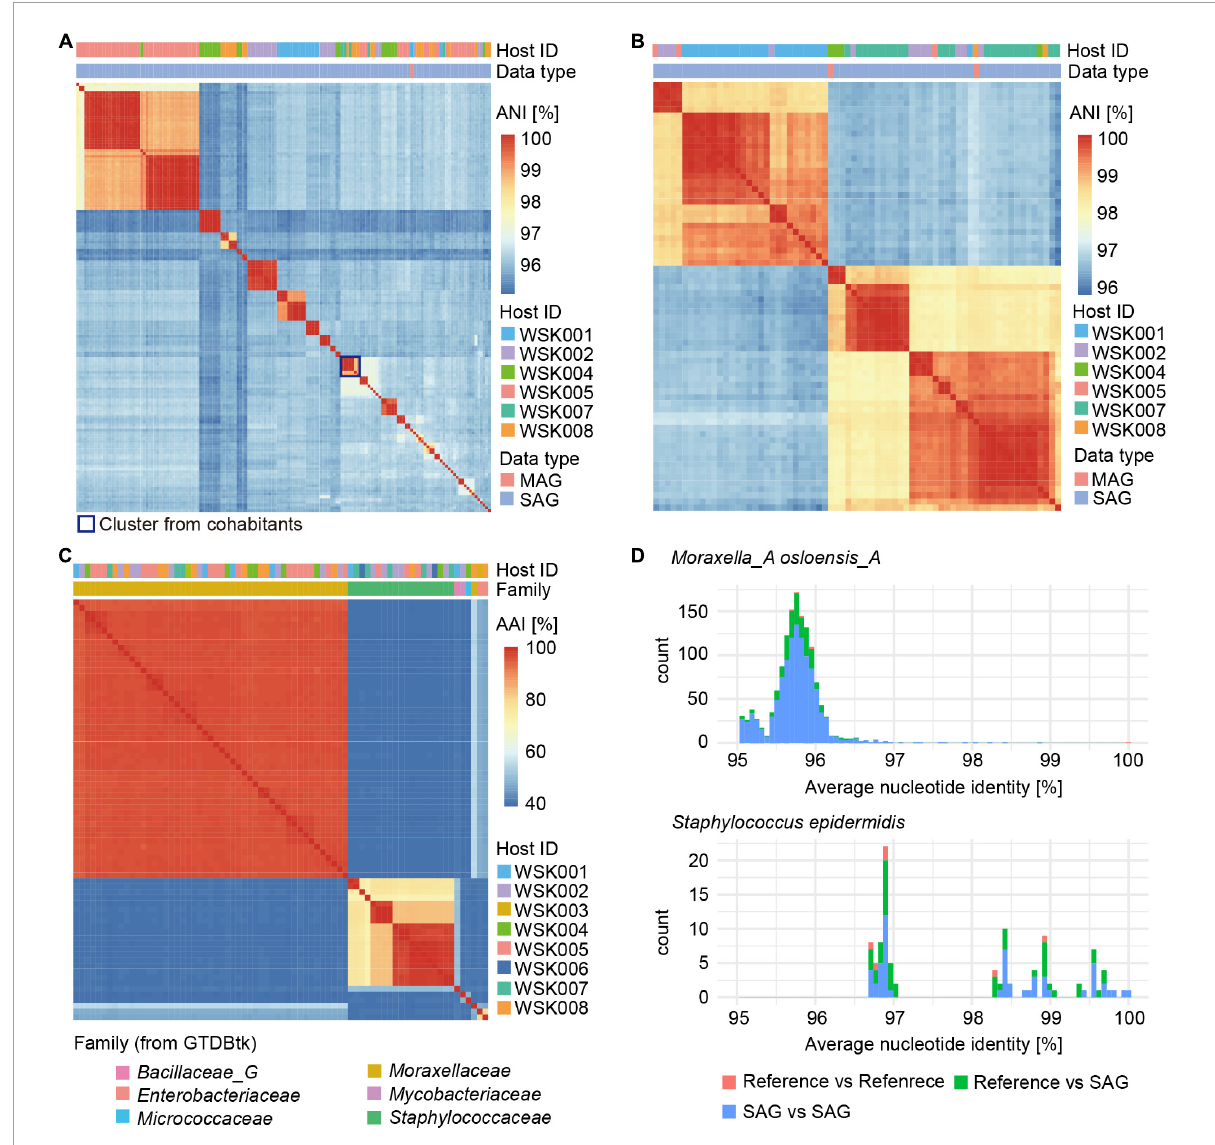
FIGURE3 Obtaining strain-resolved genomes for Moraxella osloensis and Staphylococcus epidermidis . (A,B) Clustering of single-amplified genomes (SAGs) and metagenome-assembled genomes (MAGs) for (A) M. osloensis and (B) S. epidermidis based on the average nucleotide identity (ANI). Based on the SAG clustering (ANI > 99%, TNF > 90%, single-copy marker gene > 99.9%), composite SAGs (CoSAGs) representing each bacterial strain were constructed for each host. (C) Clustering of high-quality (HQ) SAGs for obtaining strain-resolved genomes, including CoSAG, for M. osloensis and Staphylococcus spp., and other skin bacteria species based on average amino acid identity (AAI). (D) Distribution of pairwise ANIs for strain-resolved HQ SAGs of M. osloensis and S. epidermidis with known reference genomes. In panels (A–C) , HQ SAGs (Completeness > 90%, Contamination < 5%) are